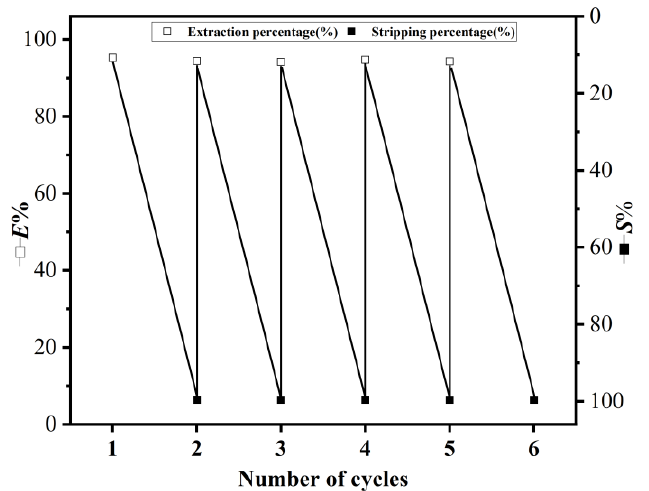
Figure 13. The reusability of the DES extractant (molar ratio: HTTA/TOPO = 2/1) was explored by determining E % and S %. The initial concentration of Li + was 25 ppm (volume ratio: aqueous phase: organic phase = 4:1). Stripping step: 0.1 M HCl was used as the stripping agent with aqueous phase: organic phase = 4:1.